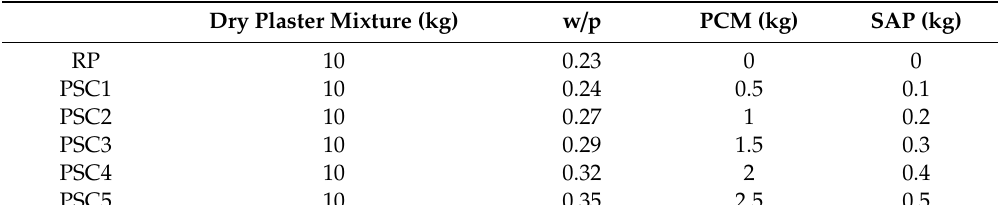
Table 1. Plasters composition.